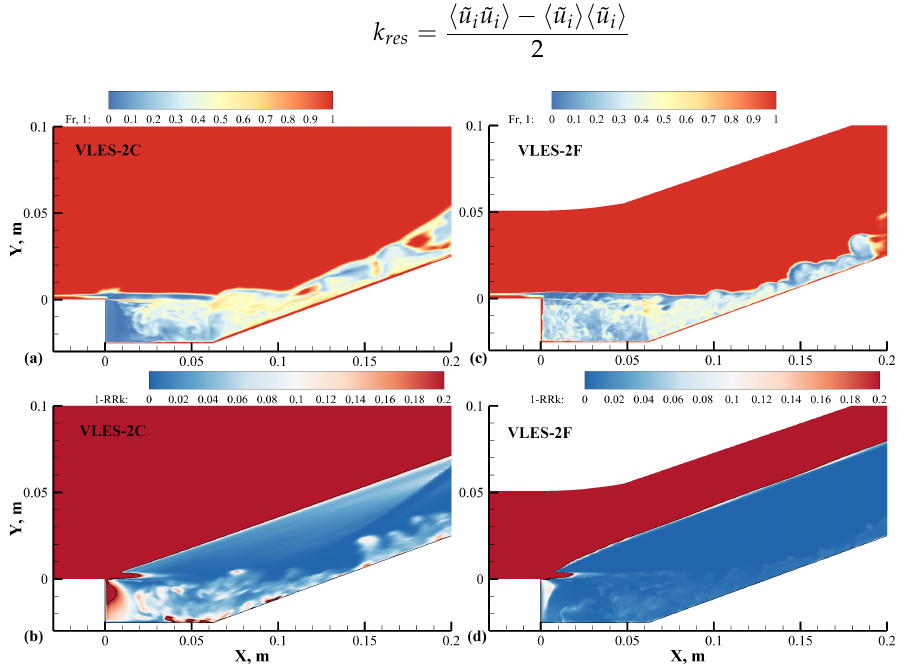
Figure 13. Contours of ( a , c ) resolution control function and ( b , d ) unresolved ratio of turbulent kinetic energy from the VLES-2 results (left: coarse mesh, right: fine